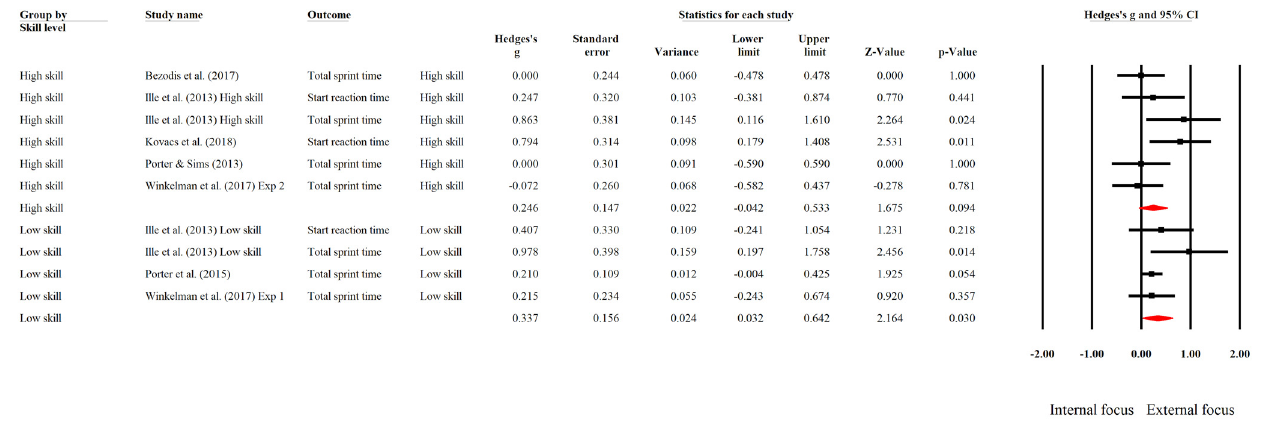
Figure 3. Forest plot of subgroup analysis for comparing the attentional focus effect on sprint performance between high-skill and low-skill sprinters.